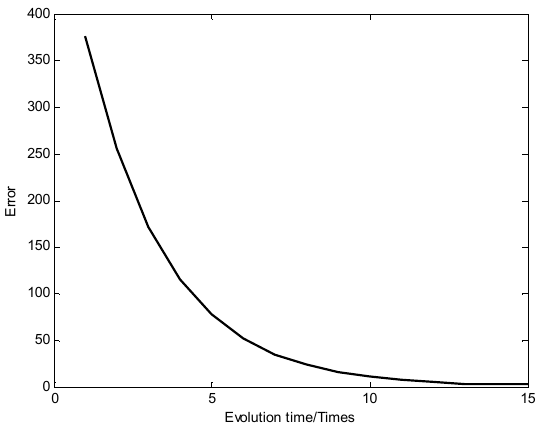
Figure 7. The relationship curve between error and evolution time.